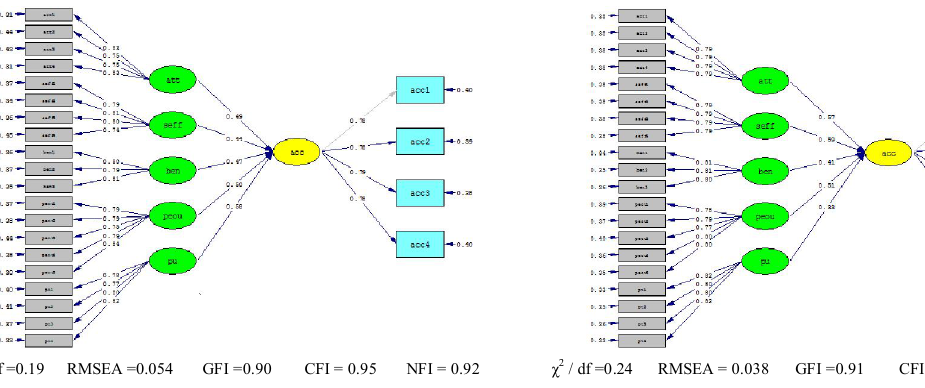
Fig. 2. The results of the implementation of structural equation modeling